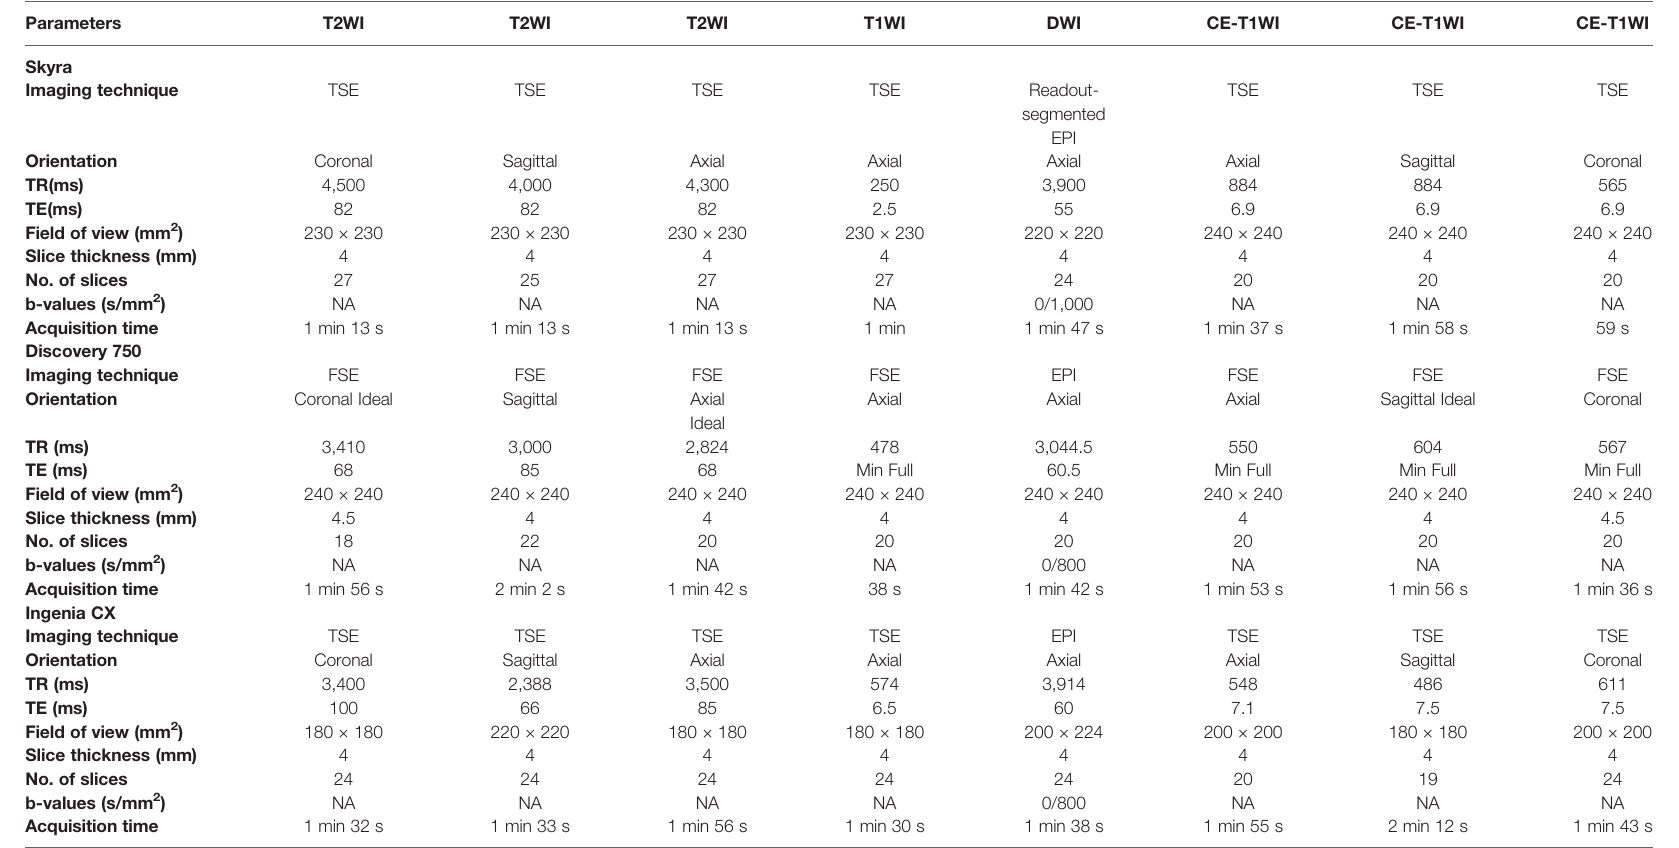
TABLE 2 | MRI main sequence